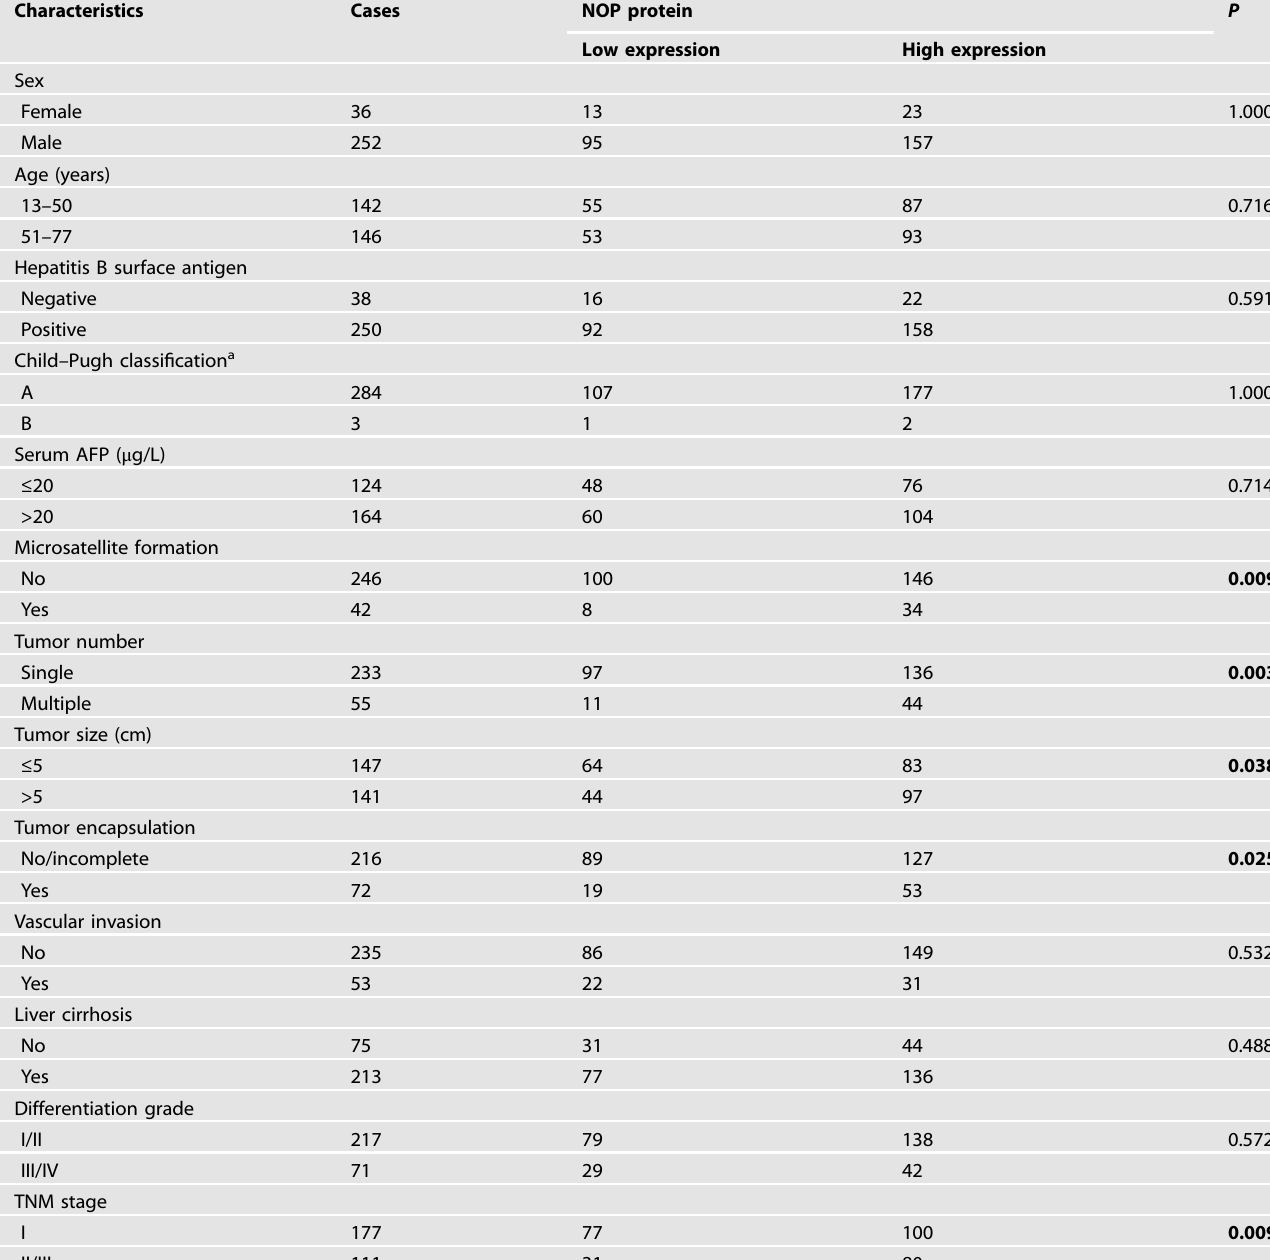
Table 1. Correlation of NOP expression with the clinicopathologic features of 288 patients with HCC.